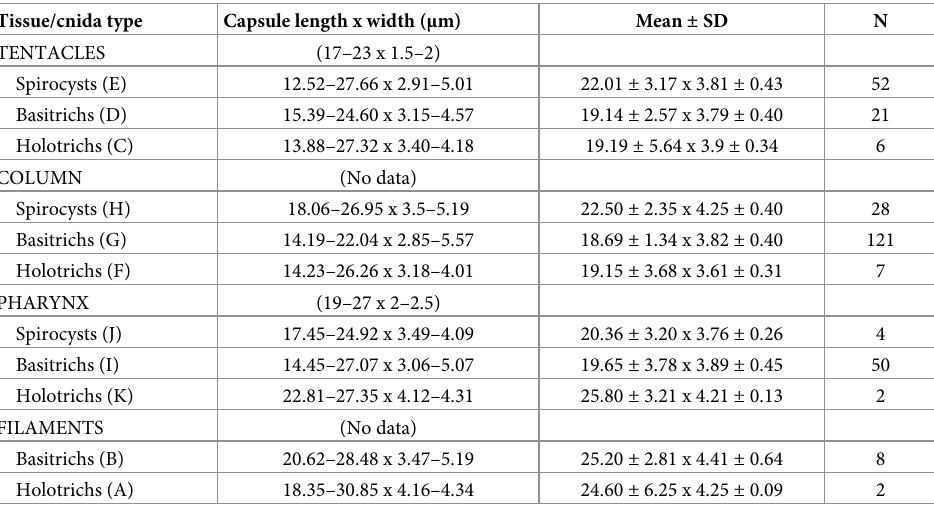
Table 2. Size and distribution of cnidae of Peachia chilensis